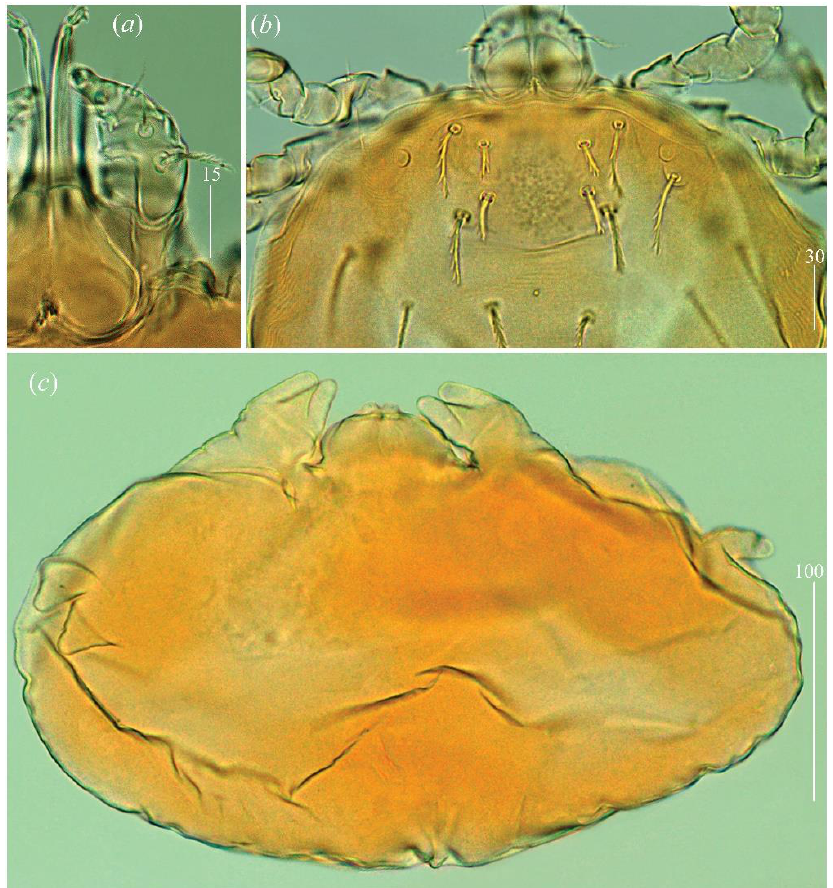
Figure 20. Geckobia indica Hirst, 1917: ( a ) part of gnathosoma of protonymph in dorsal view; ( b ) outlined propodonotal shield in larva; ( c ) chrysalis (tritonymph) in ventral view. G. indica Hirst, 1917: 139; 1926: 185 Figure 8; Haitlinger 2005: 96. Nymphchrysalis (range for one specimen). Idiosoma 165 long and 360 wide with barely Redescription. discernible